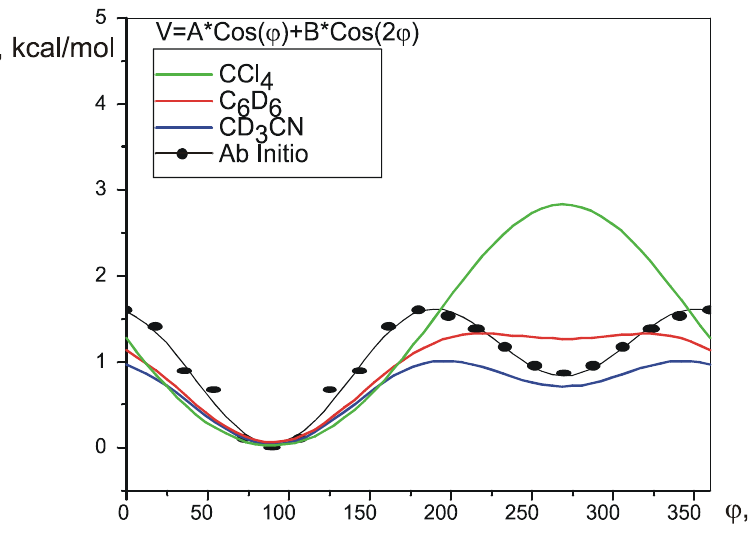
Figure 6. Pseudorotation potential for